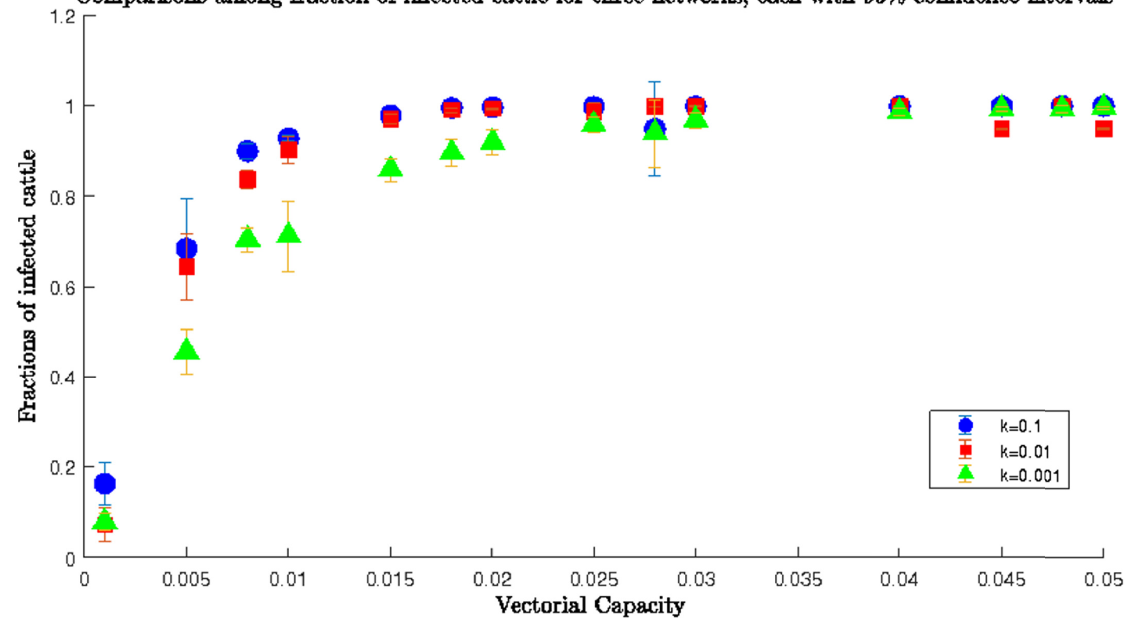
Fig 7. Comparisons among fractions of infected cows for heterogeneous network for three different values of k and for upper range of β ; the fractions of infected reaches towards 1 rapidly and when the value of transmission rate is 0.03, the fraction of infected become one for all three